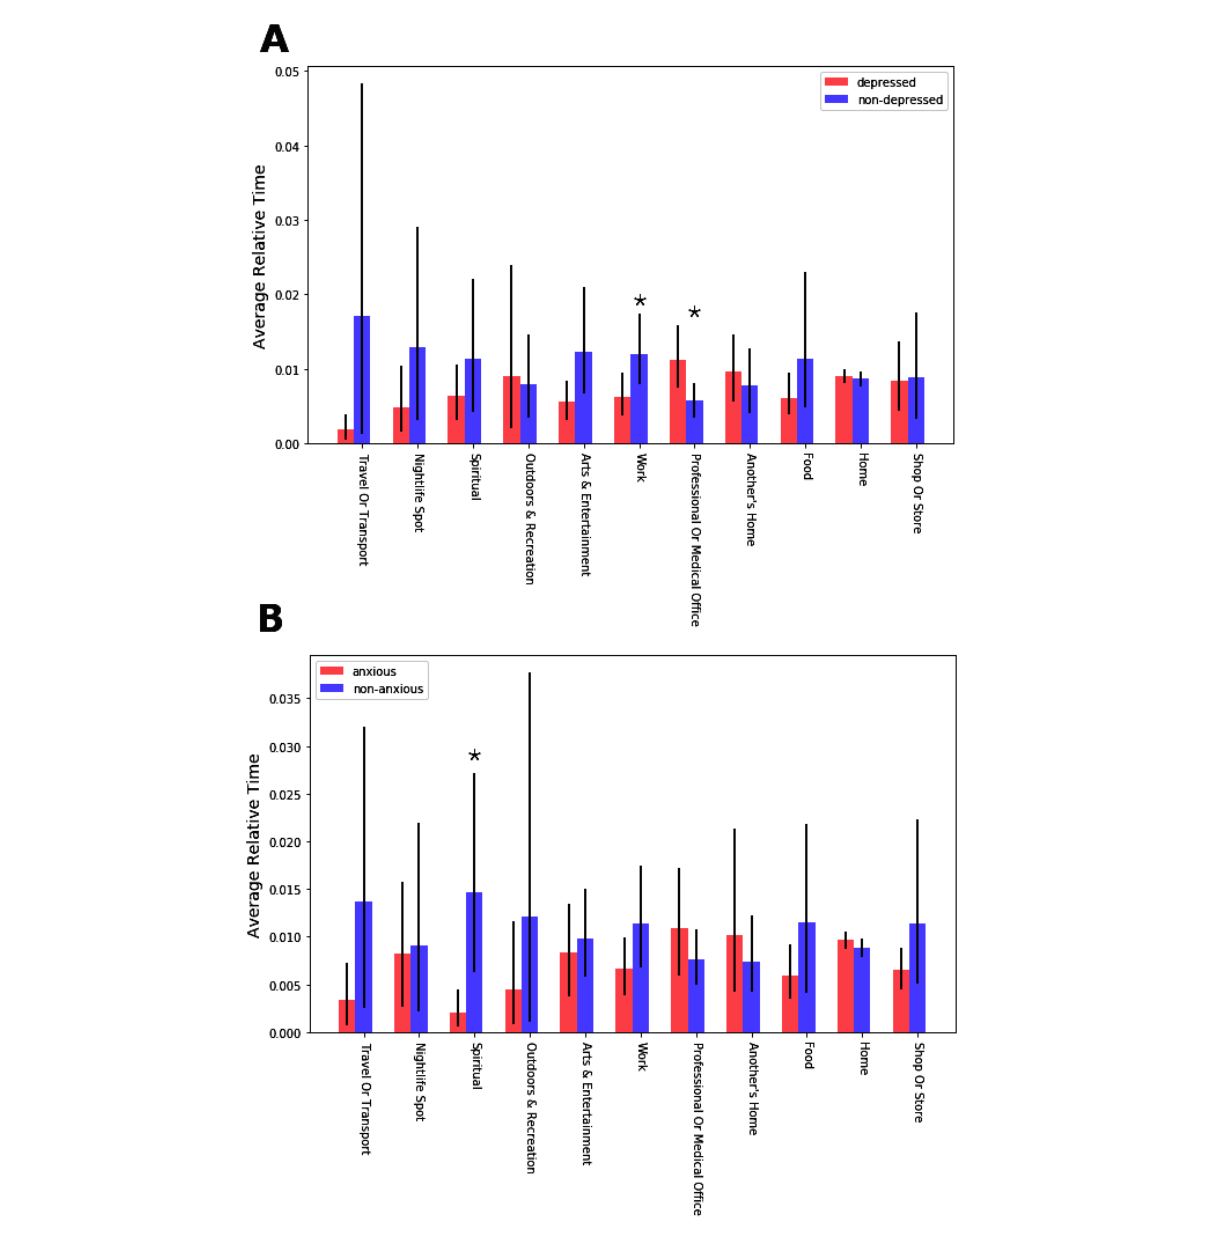
Figure 10. The relationship between semantic location visit duration, depression, and anxiety. Each bar shows the average time spent at each location by (A) depressed versus nondepressed and (B) anxious versus non-anxious groups, relative to the total time spent by all participants in that location. Error bars show 95% CIs. Both mean and CIs are obtained by bootstrapping over 1000 iterations. Stars indicate significant difference between the means, obtained using a 2-sample t-test at the P<.05 level. However, adjusting for multiple comparisons, these differences are all